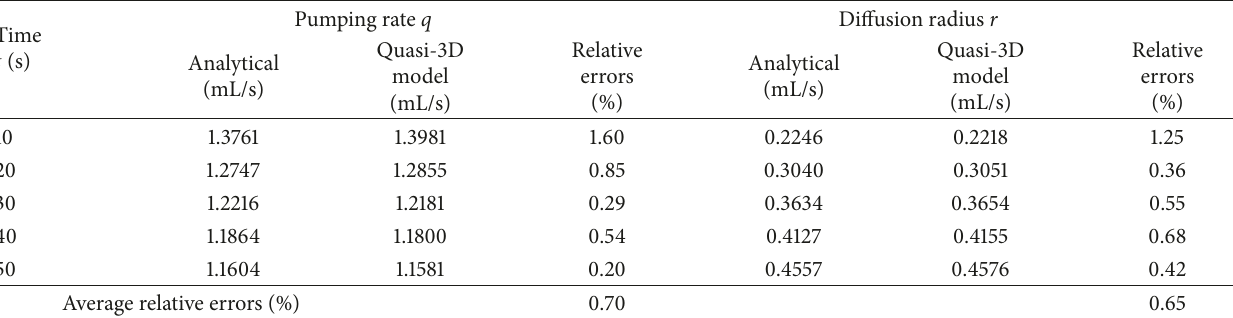
Table 7: Variations of the diffusion radius and the pumping rate with time in Case